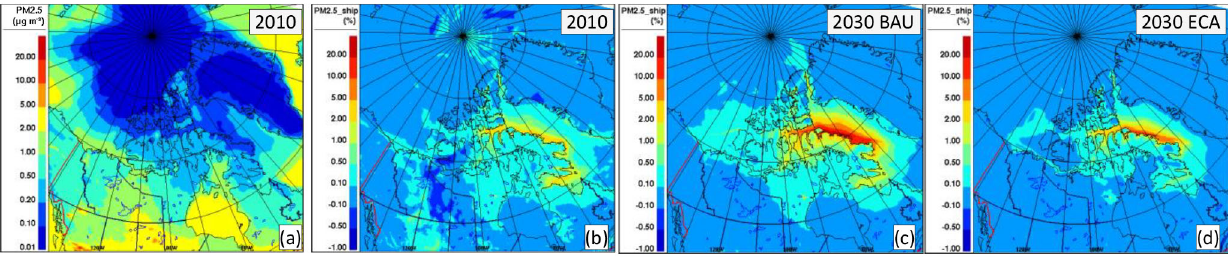
Figure 10. Modelled mean ambient PM 2 . 5 concentrations for July–August–September (shipping season) of 2010 base year (a) , and relative contribution from Canadian Arctic shipping emissions for the 2010 base year (b) , 2030 BAU (c) , and 2030 ECA (d)